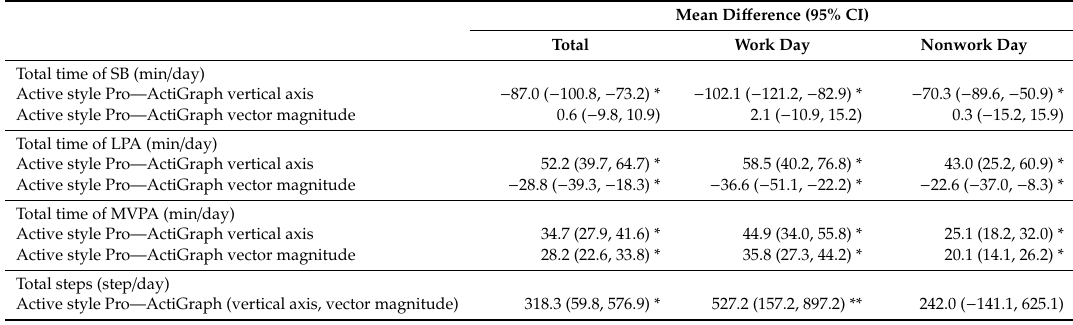
Table 3. The differences of PA outputs between Active style Pro and ActiGraph using the correction factors.